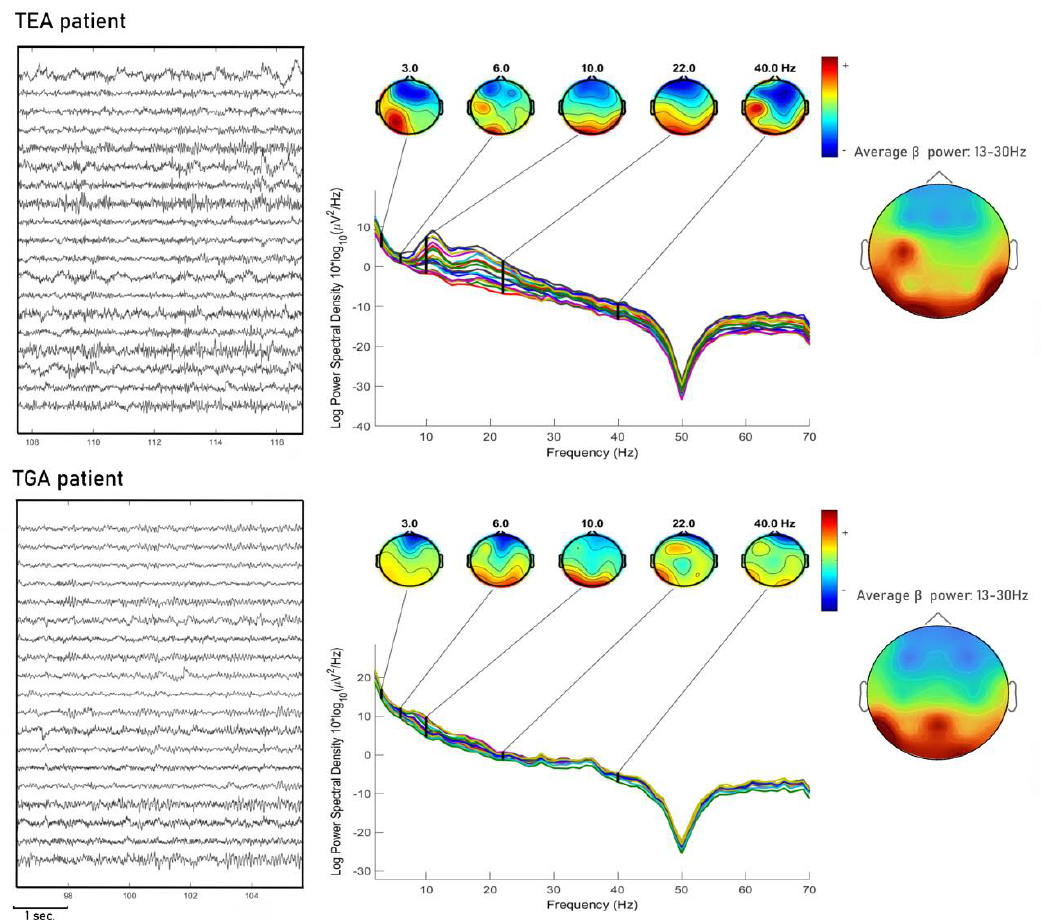
Figure 2. We show one exemplary subject for each condition TEA and TGA, PSA is shown with topographies of instantaneous frequency at each band (delta, theta, alpha, beta, gamma). Moreover, for each condition we show the topography in average beta power (13–30 Hz). Spectral activity in the TEA patient is more scattered and beta power topography appears to be more asymmetric compared to TGA patients.